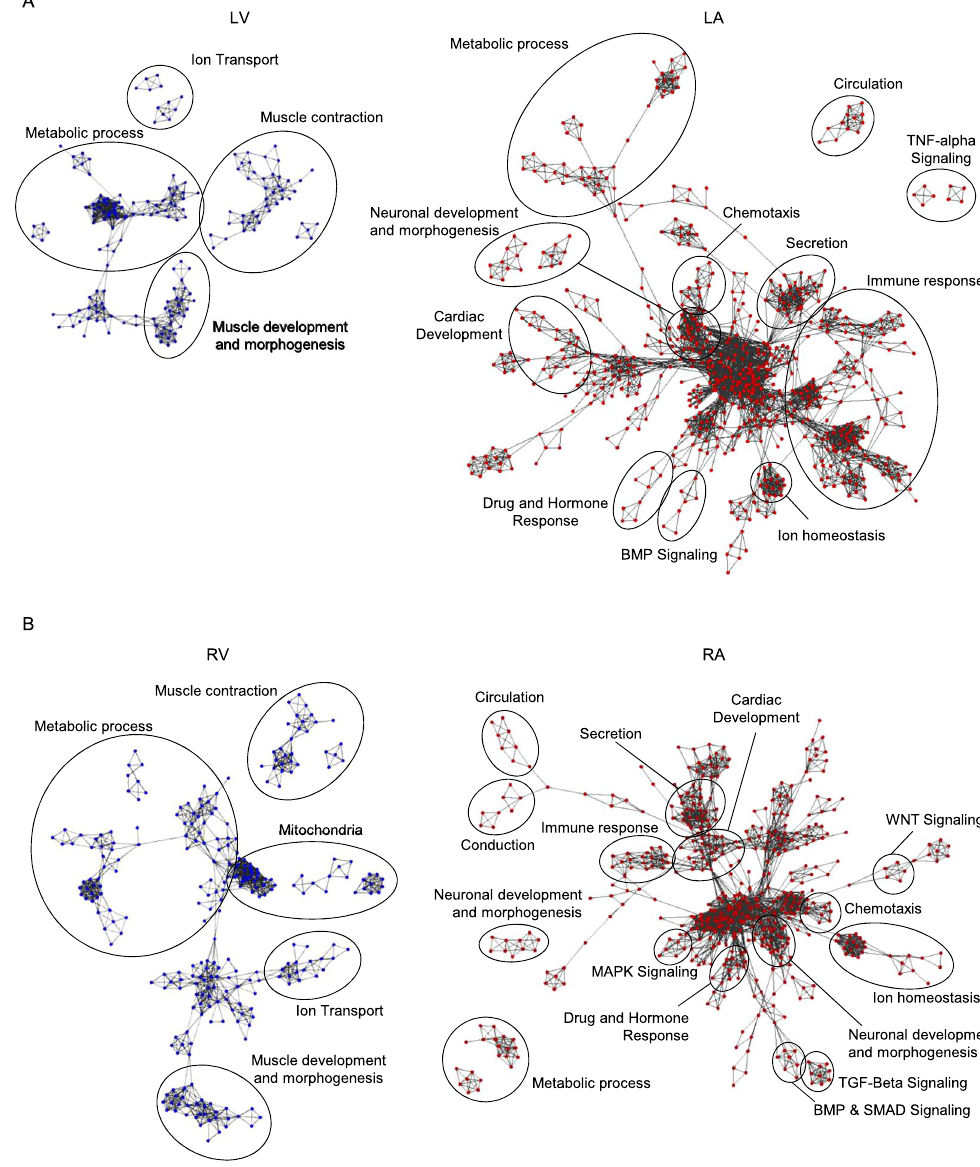
Figure 3. Biological processes enriched in non-failing human atria and ventricles are distinct. Maps of biological processes significantly ( P < 0.05) enriched in LA vs LV ( A ) and RA vs RV ( B ) were generated using the Enrichment map tool 34 , as described in Methods and Materials. Nodes represent individual biological process terms. Clusters of similarly enriched biological process terms are indicated by the circles; complete lists of circled biological terms, for comparisons between the LA and LV or the RA and RV, are provided in the data